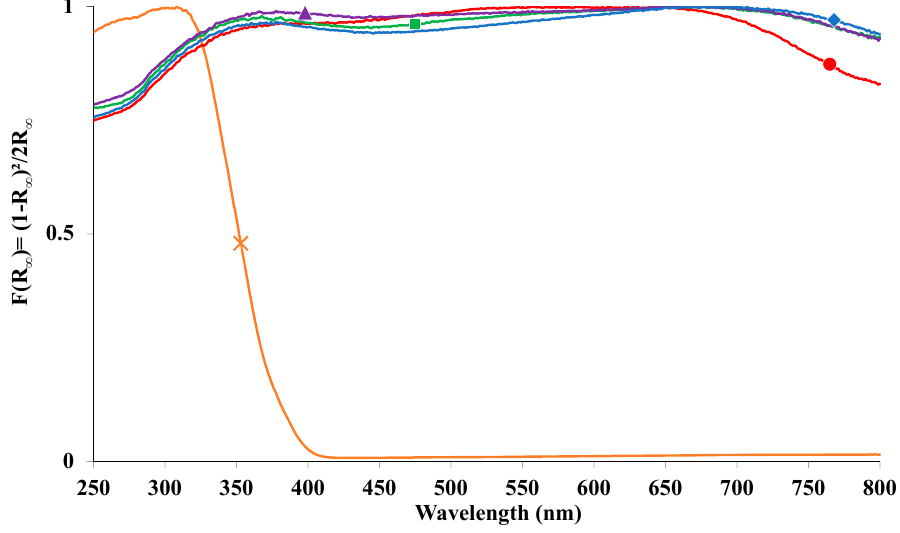
Figure 7. UV–Visible absorption spectra of ( (cid:8) ) pure ZnCo 2 O 4 , ( (cid:4) ) ZnCo 2 O 4 / SnO 2 -10%, ( (cid:78) ) Figure 7. UV-Visible absorption spectra of ( ● ) pure ZnCo 2 O 4 , ( ■ ) ZnCo 2 O 4 /SnO 2 -10%, ( ▲ ) ZnCo 2 O 4 / SnO 2 -20%, ( (cid:7) ) ZnCo 2 O 4 / SnO 2 -30% and ( × ) Evonik P25. ZnCo 2 O 4 /SnO 2 -20%, ( ♦ ) ZnCo 2 O 4 /SnO 2 -30% and (×) Evonik P25.